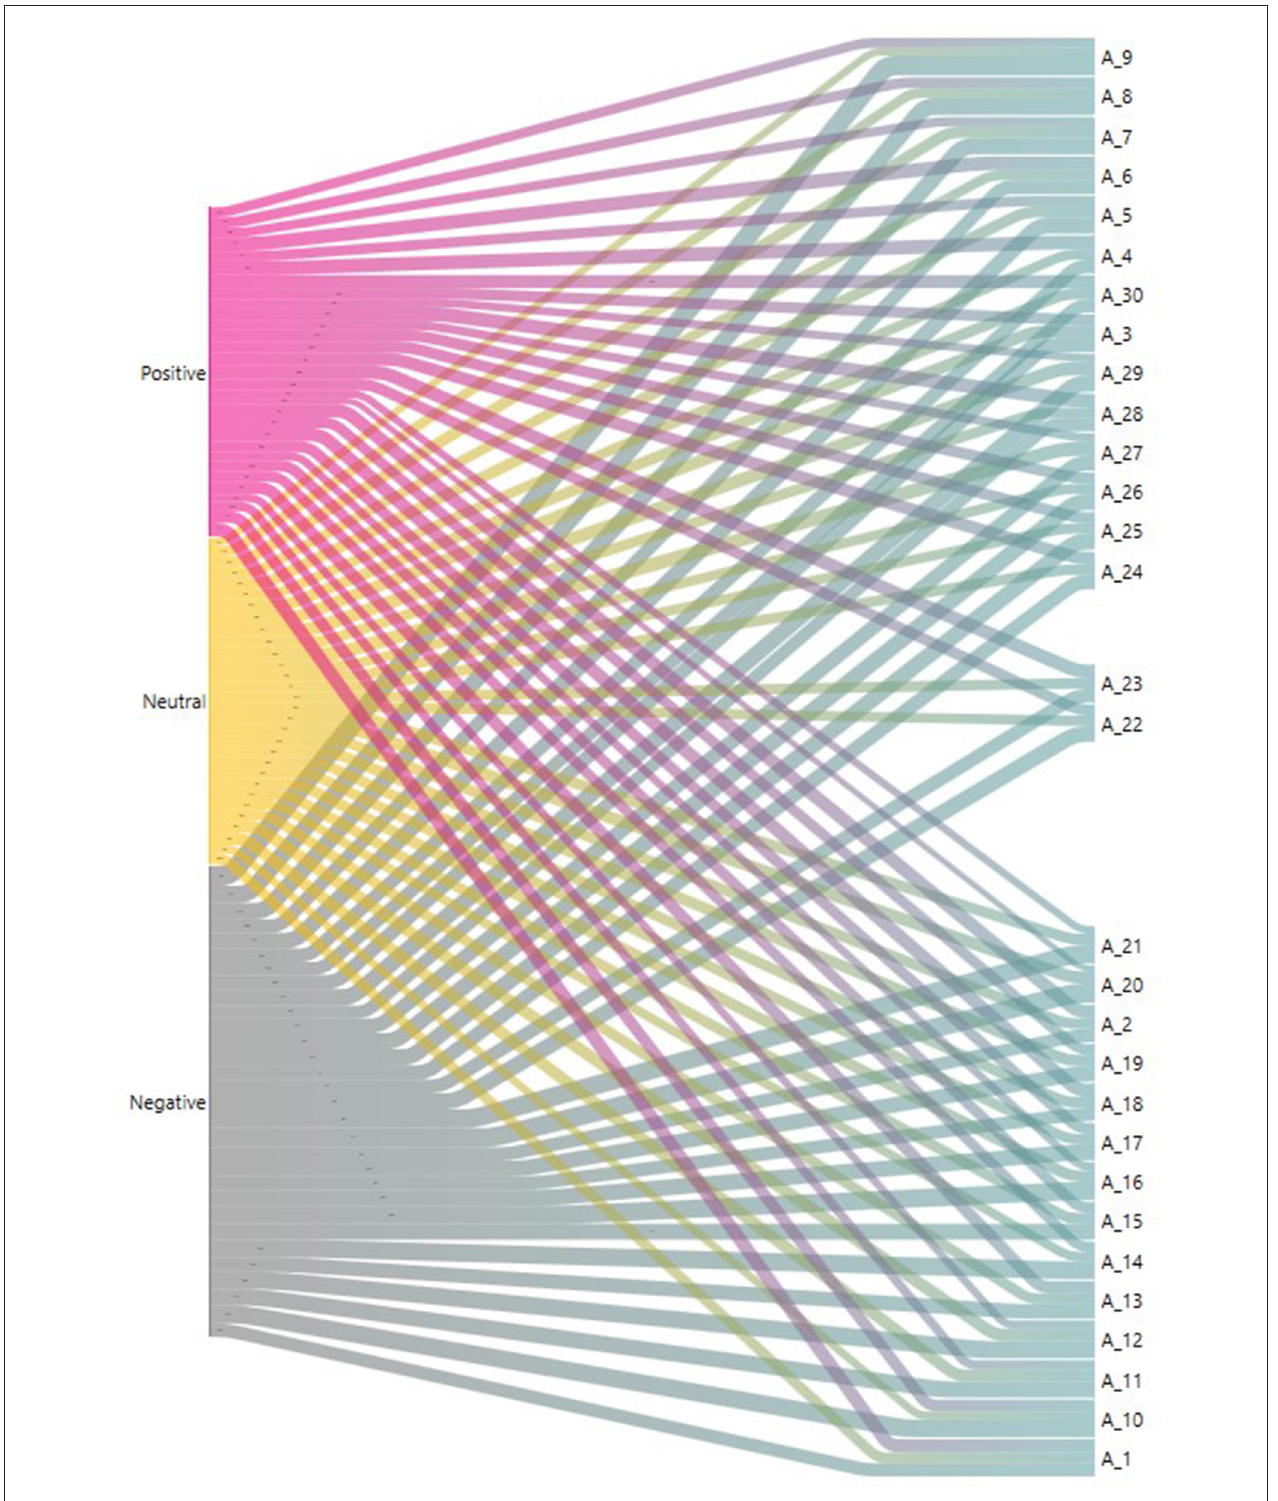
FIGURE 8 | Sankey plot of the categorization of key (positive-negative-neutral) sentences per document.